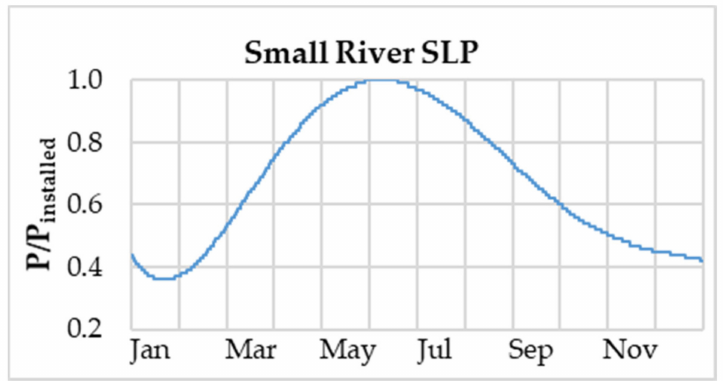
Figure 10. SLP small river, for small-scale hydro run-off power plants.